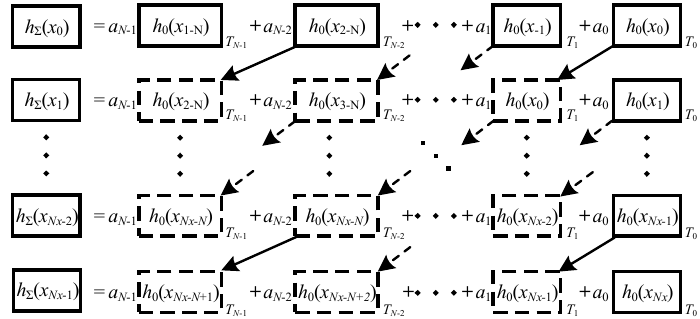
Figure 6. Illustration of the computation procedure for Equation (23) (symbols y , z , and t are omitted).